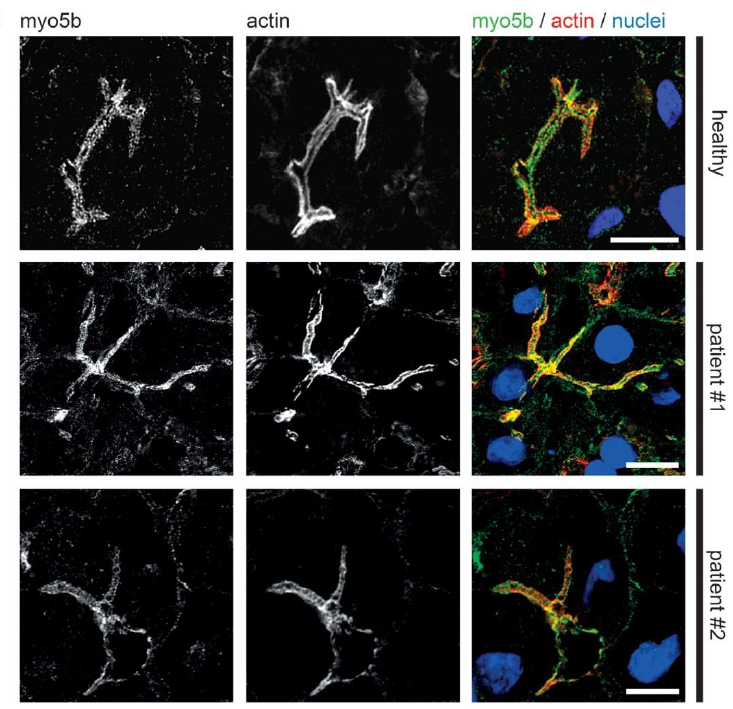
Figure 5. Localization of myo5b in MYO5B-PFIC hepatocytes. Laser-scanning immuno- fluorescence micrographs (IF) of hepatocytes from patient #1 and #2 show regular localization of mutated myo5b to the apical plasma membrane compared to healthy controls. Bile canaliculus with microvilli indicated by actin staining; scale bars = 5 µ